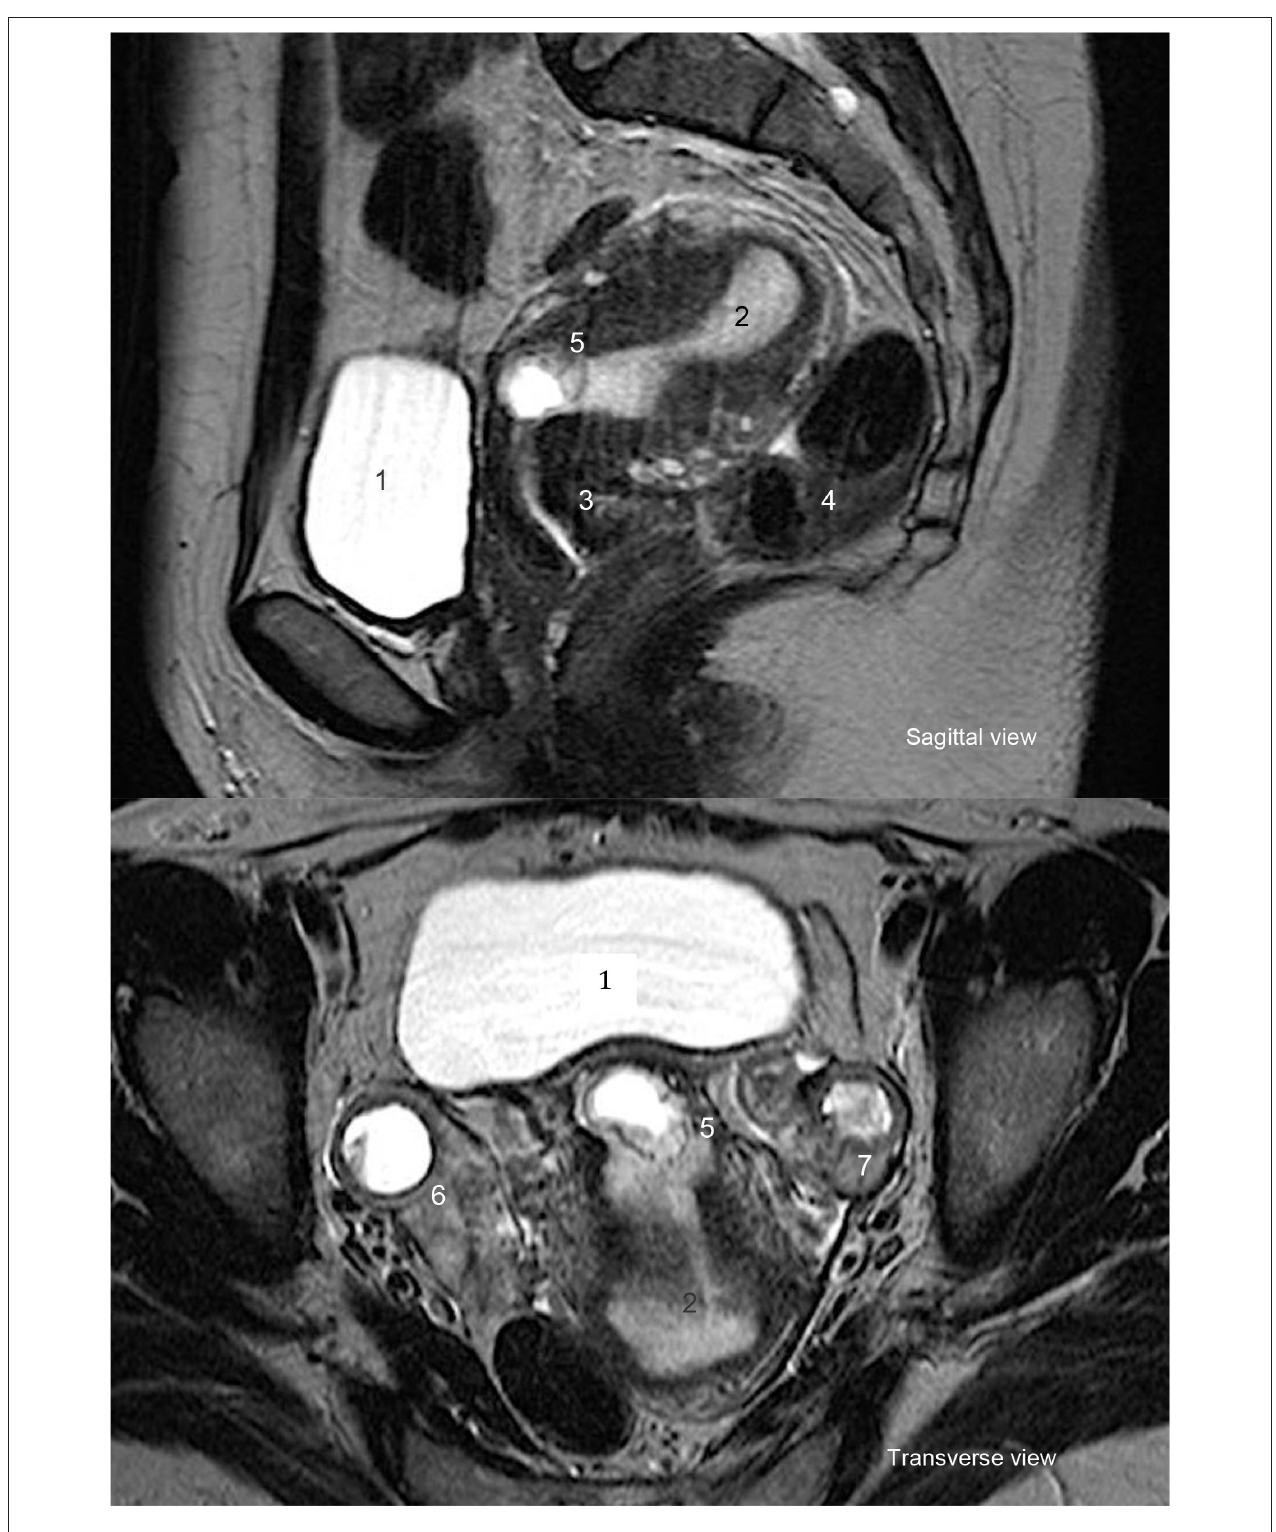
FIGURE 2 | Cesarean scar pregnancy—MRI. 1. Bladder. 2. Uterine cavity. 3. Cervix. 4.Bowel. 5. Cesarean scar pregnancy. 6. Left ovary. 7. Right ovary.